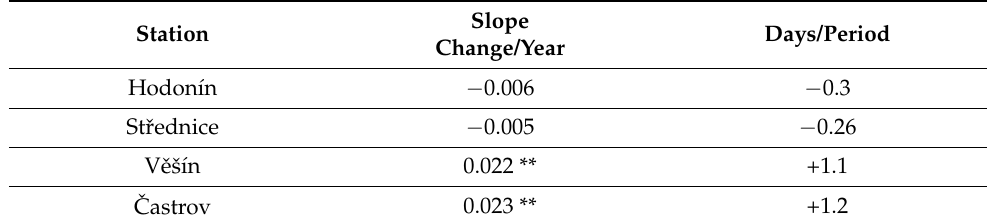
ˇCastrov 0.023 ** +1.2